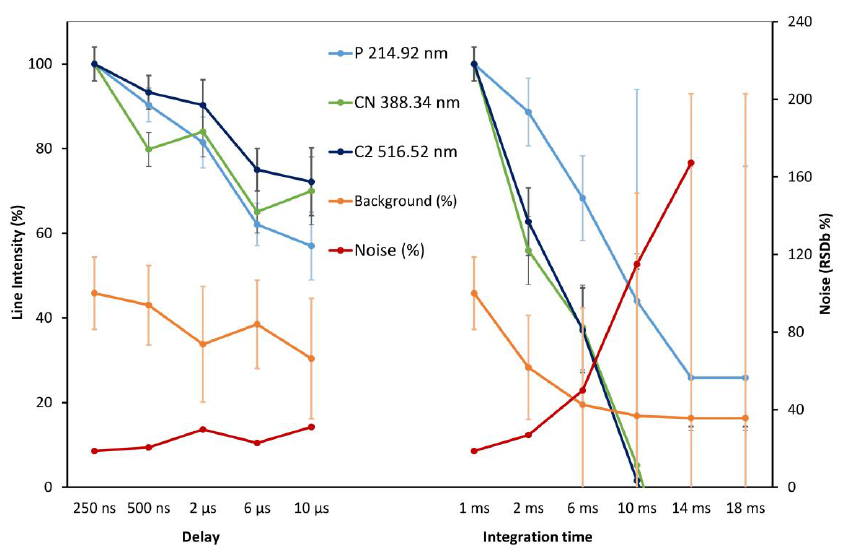
Figure 4. Delay and integration time optimization on the handheld LIBS. Lines and background intensity are normalized to the first measure. Uncertainty is calculated using the five grid replicates on the sample surface.